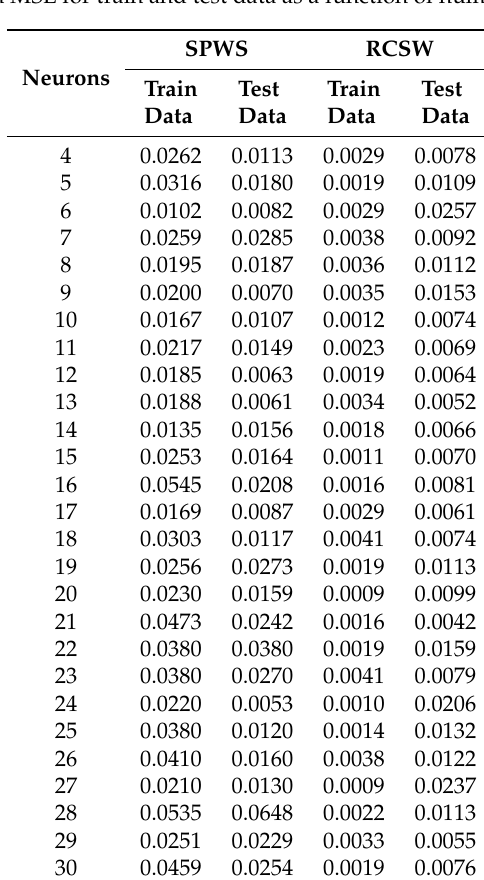
Figure 2. The network’s neuron-dependent MSE. ( a ) SPSW; train data, ( b ) SPSW; test data, ( c ) RCSW; train data, ( d ) RCSW; test data. Table 4. Mean MSE for train and test data as a function of number of